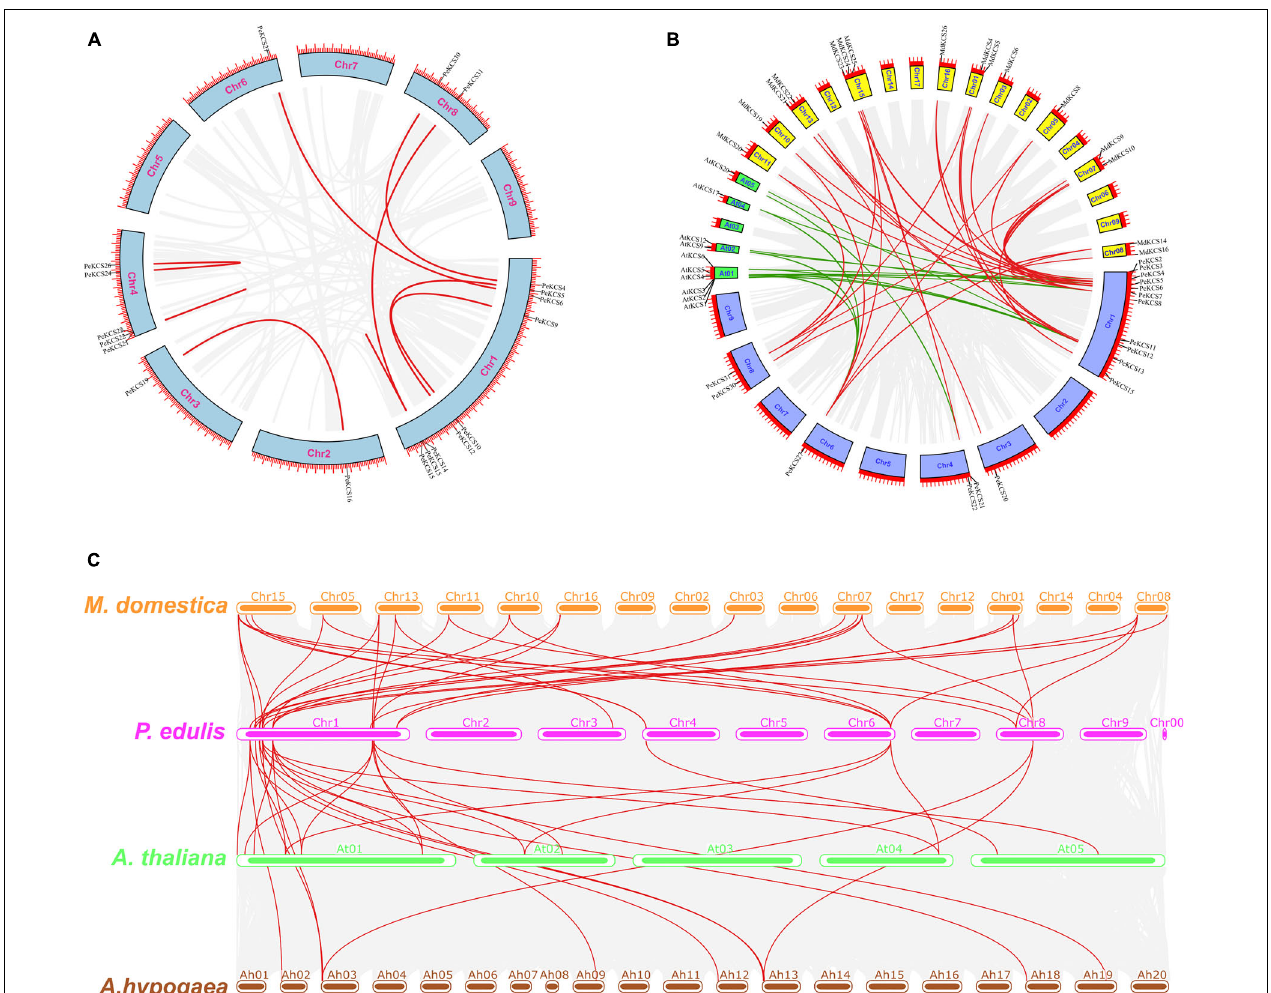
FIGURE 5 | Circos illustrations of the PeKCS genes duplication and multiple collinearity analysis of KCS genes between P. edulis, A. thaliana, M. domestica, and A. hypogaea species. (A) Gene duplication of KCS genes in P. edulis . The background gray lines show all the syntenic blocks in the passion fruit genome, and the red lines show the segmental or tandem duplication link regions among PeKCS genes. The approximately location of PeKCS genes are labeled with a short gray line outside with gene names. (B) Orthologous of P. edulis KCS genes with A. thaliana (AtKCS) and M. domestica (MdKCS) species. Chromosomes of P. edulis are represented with Chr1–Chr9, A. thaliana with At01-At05 and M. domestica with Chr01–Chr17. The background gray lines show all the syntenic blocks genomes of different species, green lines represented the syntenic relationship among P. edulis and A. thaliana KCS genes, red lines represented the syntenic relationship among P. edulis and M. domestica KCS genes, (C) Multiple collinearity analysis of KCS genes between P. edulis, A. thaliana, M. domestica, and A. hypogaea species. The red lines represent the P. edulis KCS genes orthologous in A. thaliana , M. domestica, and A. hypogaea species, the gray lines in the background represent the collinear blocks within P. edulis and other species